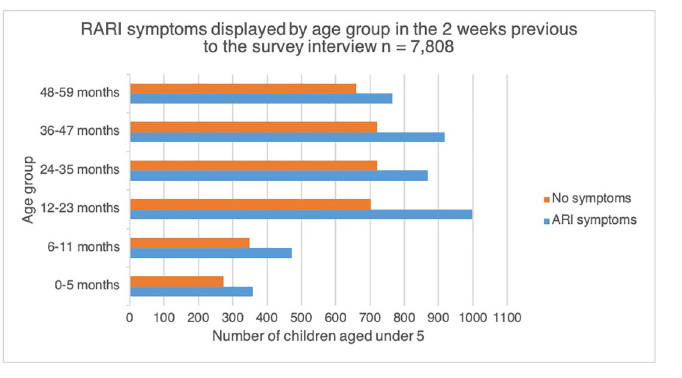
Fig 1. Presenting RARI frequency by age group in